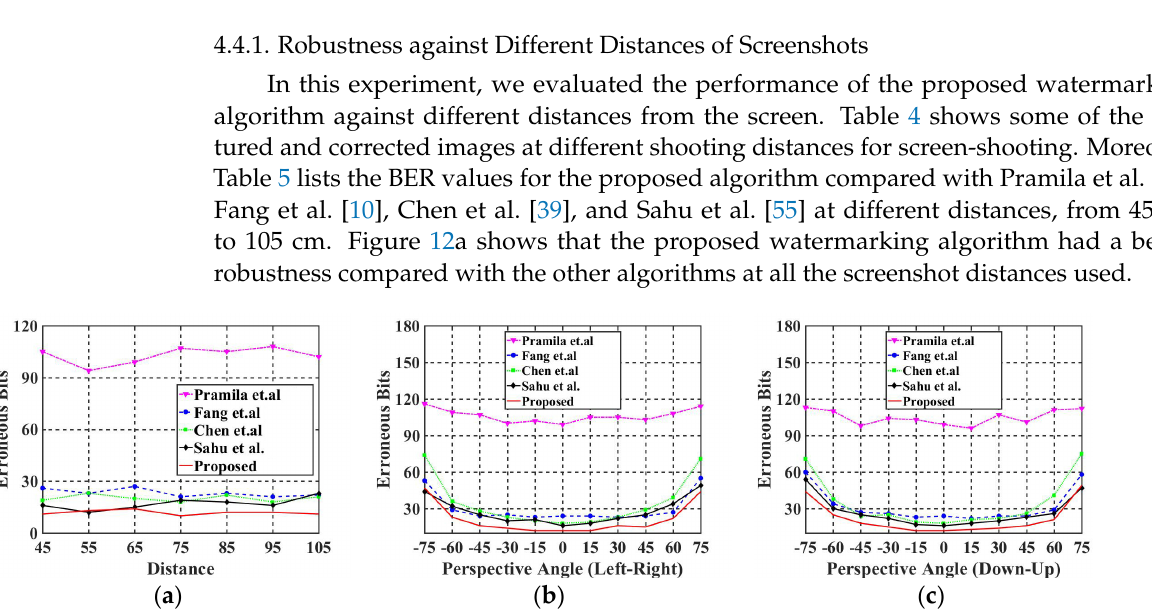
Figure 12. Comparison of BER values at different distances and angles with Fang et al. [10], Chen et al. [39], Pramila et al. [43], and Sahu et al. [55] : ( a ) BER values at different distances; ( b ) BER values at different horizontal angles; ( c ) BER values at different vertical angles.